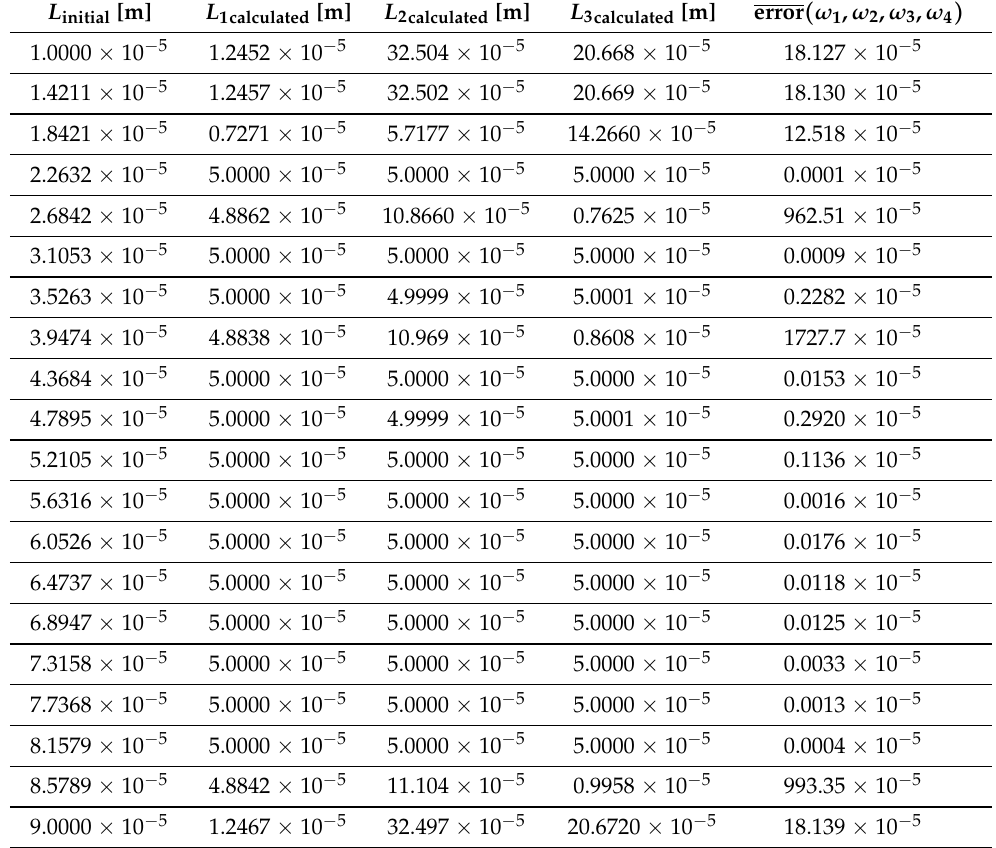
Table 10. Results for case